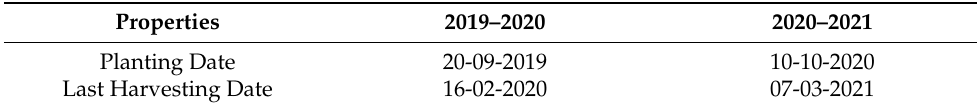
Figure 1. Location of ICAR—Indian Agricultural Research Institute, New Delhi. Table 1. Planting and harvest dates with seasonal weather data from